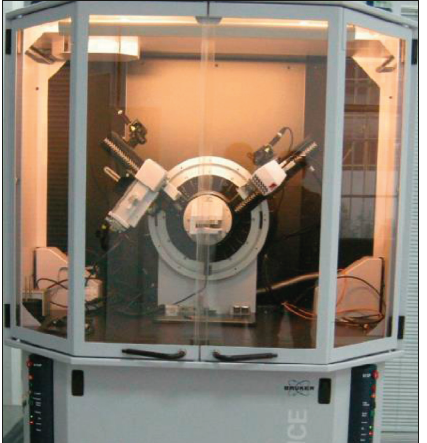
Figure 4: Bruker D8 ADVANCE X-ray power